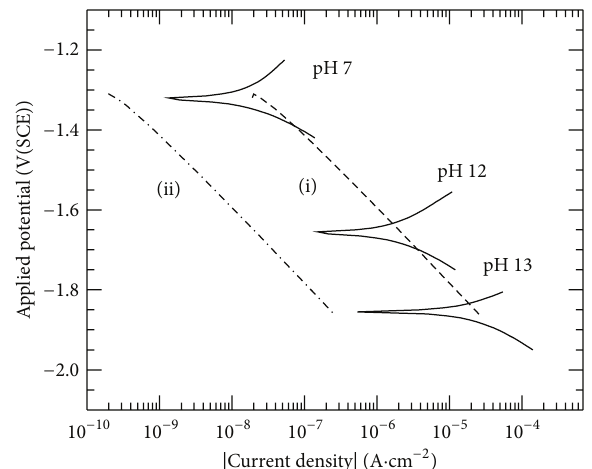
Figure 2: Metal potential as a function of current density for uncoated Al in a deaerated 0.1 M NaCl electrolyte. The graphs associated with pH 7, 12, and 13 were constructed using the parameters listed in Table 1. The dashed lines represent the metal potential and current density relationships for (i) uncoated Al and (ii) coated Al at an open circuit condition for the pH range of 7 to